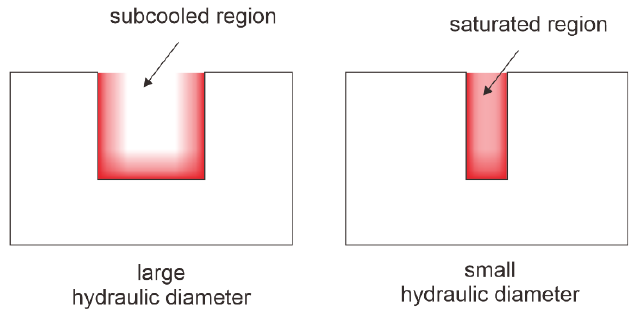
Figure 6. Comparison of thermal boundary layers on large and small hydraulic diameters.